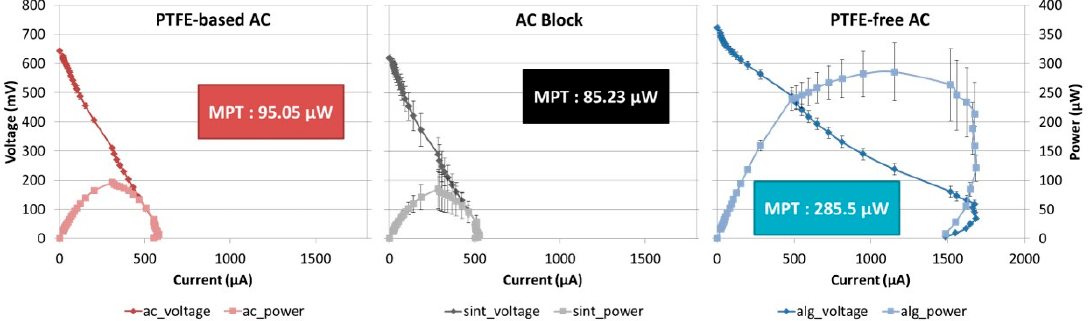
Figure 3. Polarisation results of the three types of MFCs examined. (n = 3).